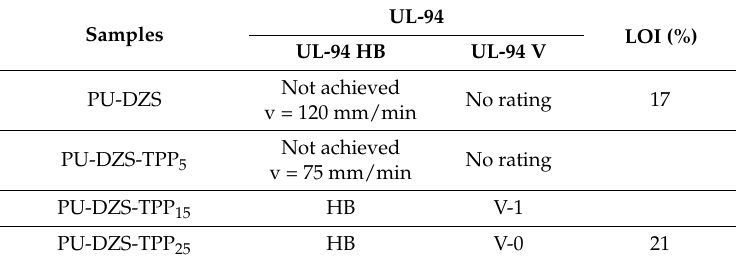
Table 1. UL-94 and LOI results for PUF-DZS and PUF-DZS containing